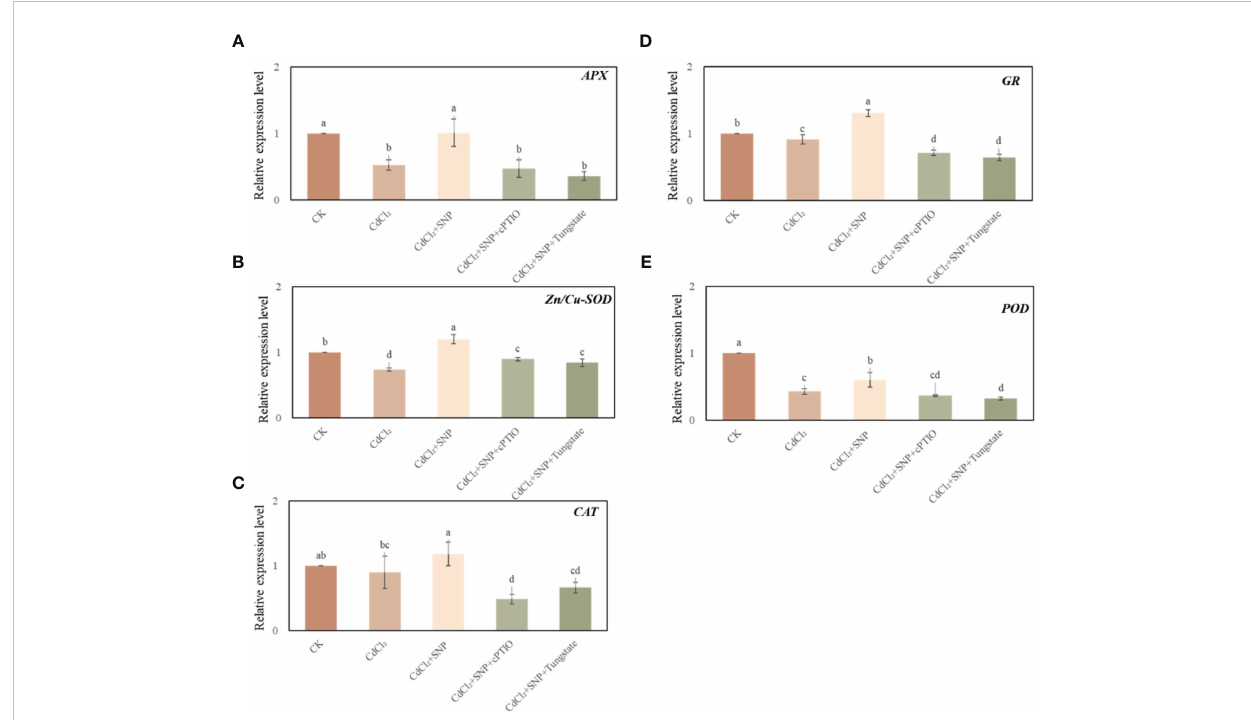
FIGURE 5 Effect of NO on the expression level of APX ( A ), Zn/Cu-SOD ( B ), CAT ( C ), GR ( D ) and POD ( E ) in cucumber explants under Cd stress at 48 (h) Explants were incubated for 2 days with distilled water (CK) or 1 m M CdCl 2 , 1 m M CdCl 2 +10 m M SNP, 1 m M CdCl 2 + 10 m M SNP + 200 m M cPTIO, 1 m M CdCl 2 + 10 m M SNP + 200 m M Tungstate. The values (means ± SE) are the average of three independent experiments. Bars with different letters are signi fi cantly different at P < 0.05 according to Duncan ’ s multiple range test.